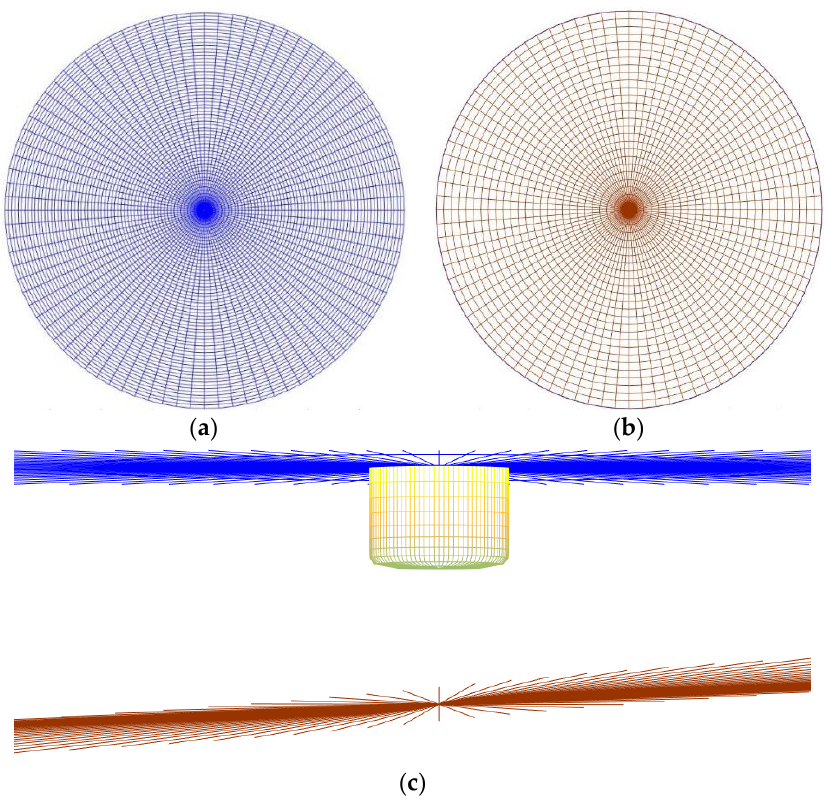
Figure 1. Computational meshes on ( a ) free surface, ( b ) bottom, and ( c ) WEC